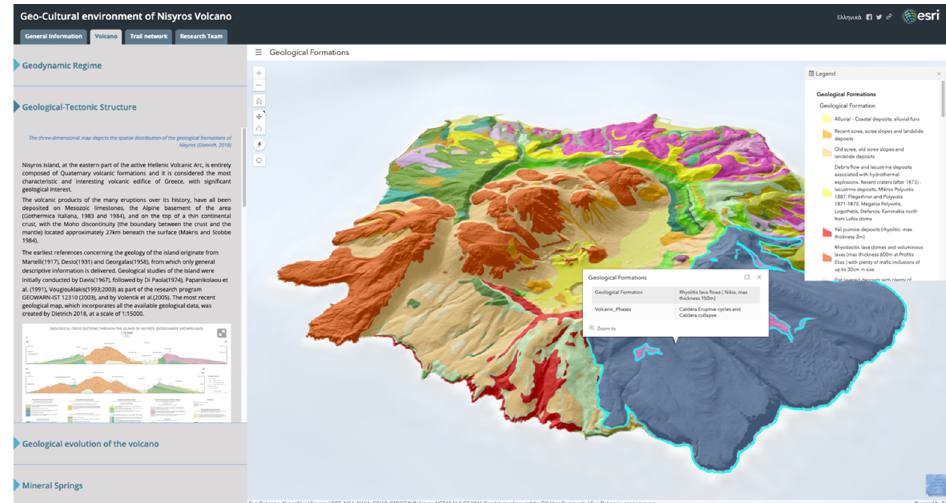
Figure 12 . Screenshot showing part of the narration about the geological–tectonic structure of the island accompanied by a 3D interactive web scene featuring the spatial distribution of the geological formations. Users can select a formation to get further information.